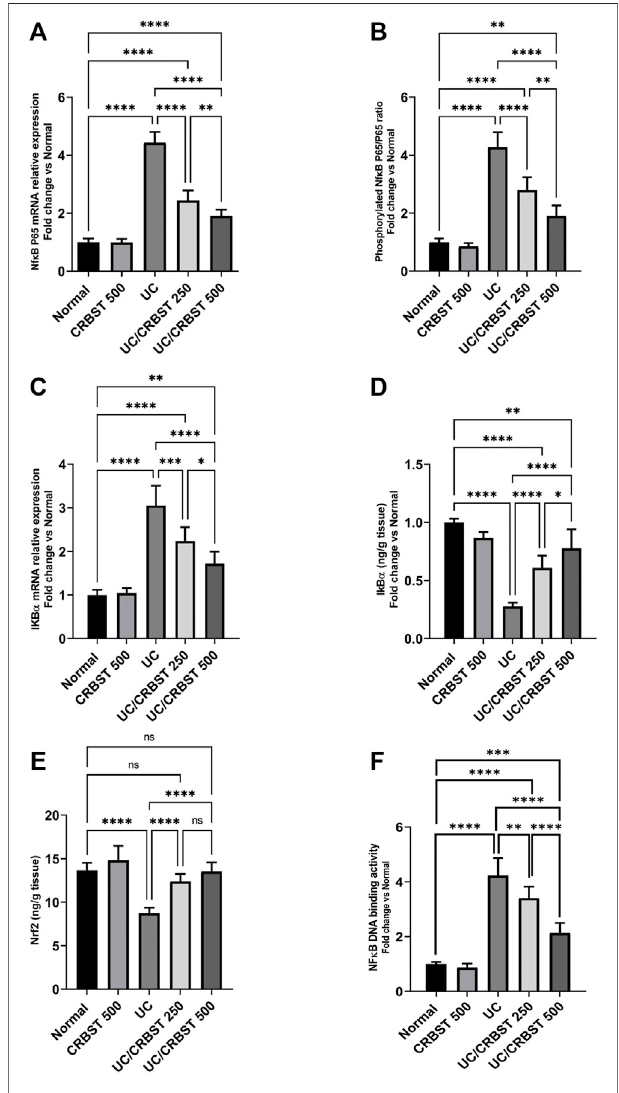
FIGURE6| Effect ofCRBST 250and500 mg/kgonNF- κ Bp-65mRNA (A) ; Phosphorylated NF- κ B p-65/p65 ratio (B) ; I κ B α mRNA (C) ; I κ B α (D) ; Nrf2 (E) and NF κ B DNA binding activity (F) in rats with AA-induced UC. Resultsareshown asthemean±SD (n=6). * p < 0.05,** p < 0.01,*** p < 0.001, **** p < 0.0001. Normal, normal control rats administered the vehicle; CRBST 500, normal rats administered carbocisteine (500 mg/kg); UC, AA- induced UC rats administered the vehicle; UC/CRBST 250, AA-induced UC rats treatedwith carbocisteine (250 mg/kg);UC/CRBST 500,AA-induced UC rats treated with carbocisteine (500